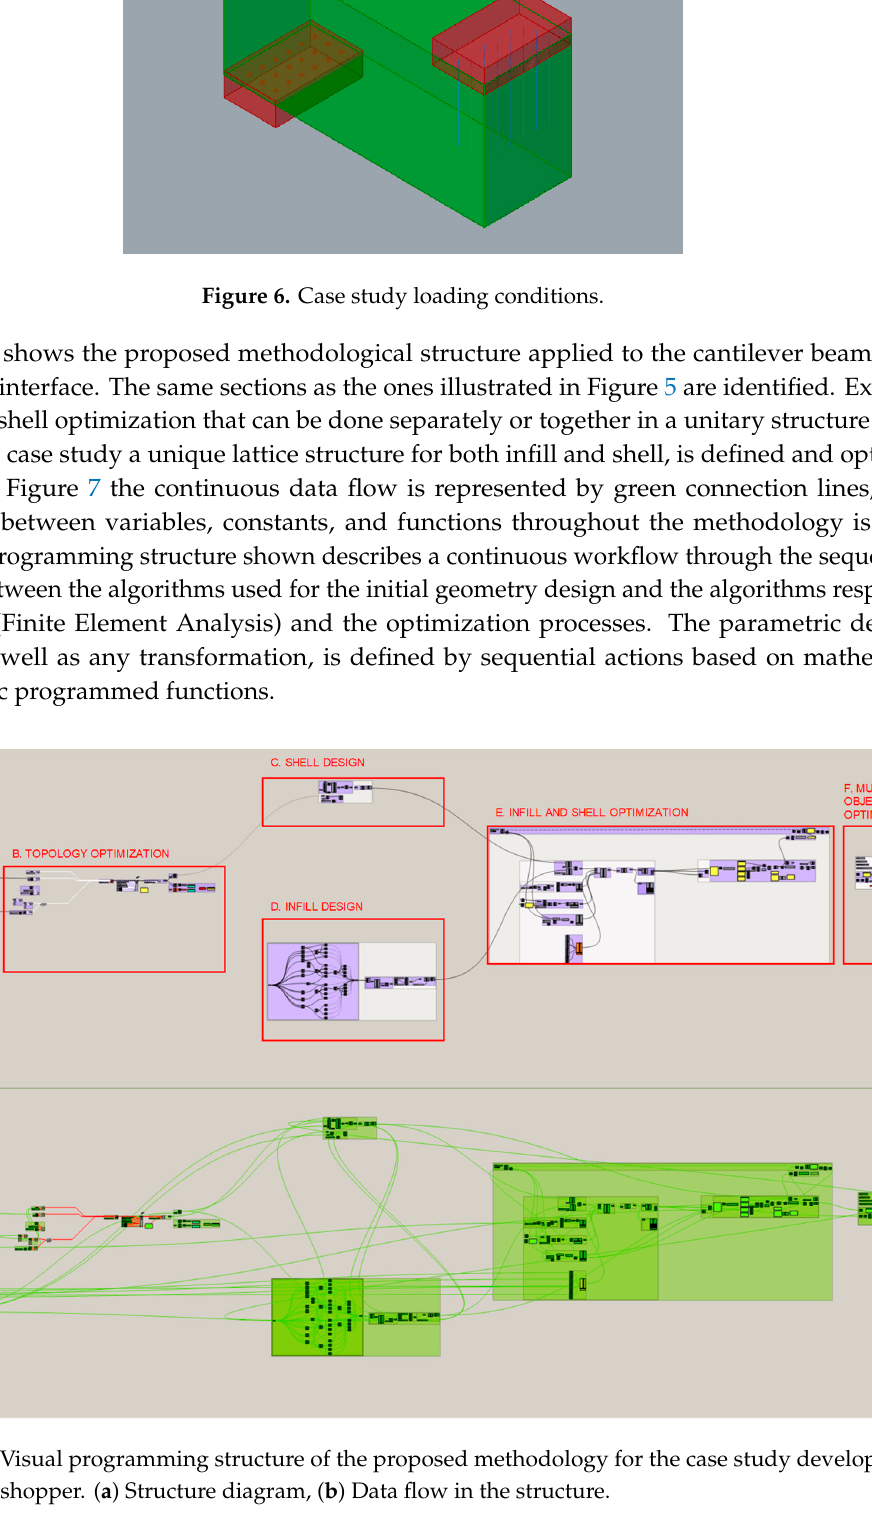
with Grasshopper. ( a ) Structure diagram, ( b ) Data flow in the structure.